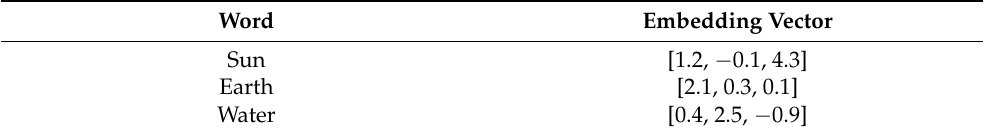
Table 5. Examples of word